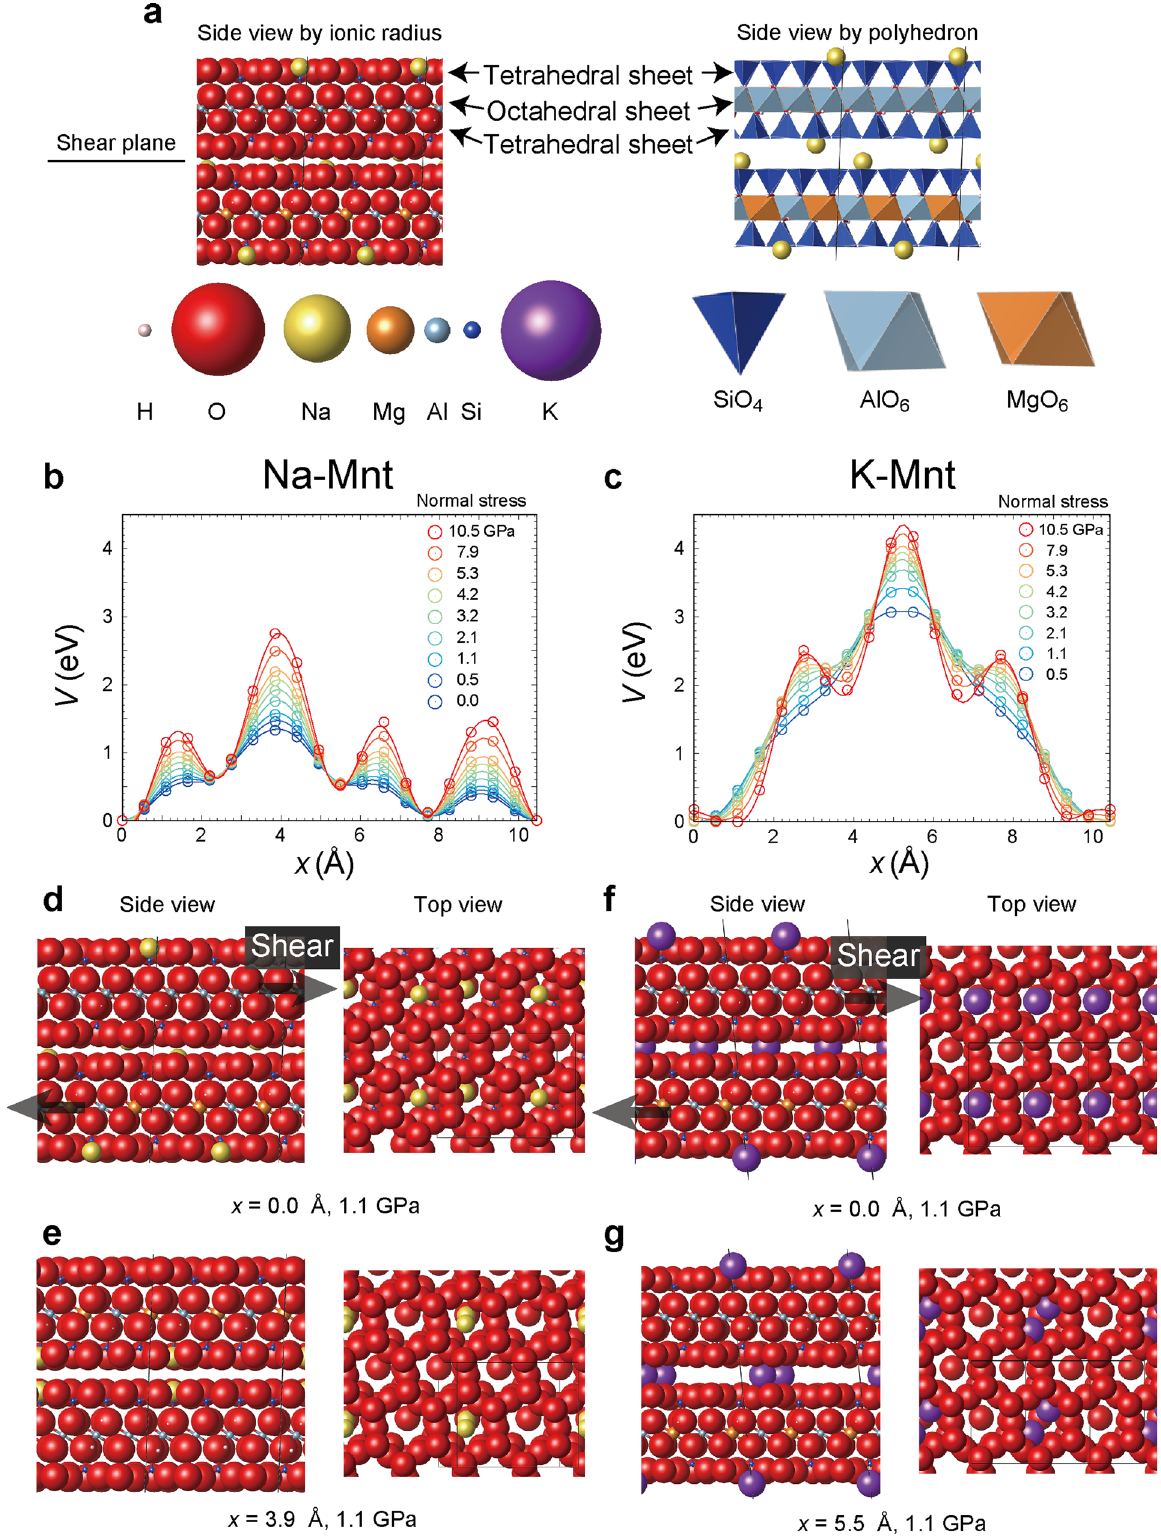
Fig. 2 Potential energy changes along [100] sliding path for montmorillonites. a Structure of Mnt shown by ionic radius and polyhedron. The tetrahedral sheet is composed of SiO 4 tetrahedra and the octahedral sheet is composed of AlO 6 and MgO 6 octahedra. Potential energy changes for Na-Mnt ( b ) and K-Mnt ( c ). Structures in the most stable stacking state ( x = 0 Å) ( d and f ) are modi fi ed by the ionic size of interlayer cations as shown in top views. Maximum potential energy is characterized by overlapping of interlayer cations for Na-Mnt at x = 3.9 Å ( e ) and for K-Mnt at x = 5.5 Å ( g ).